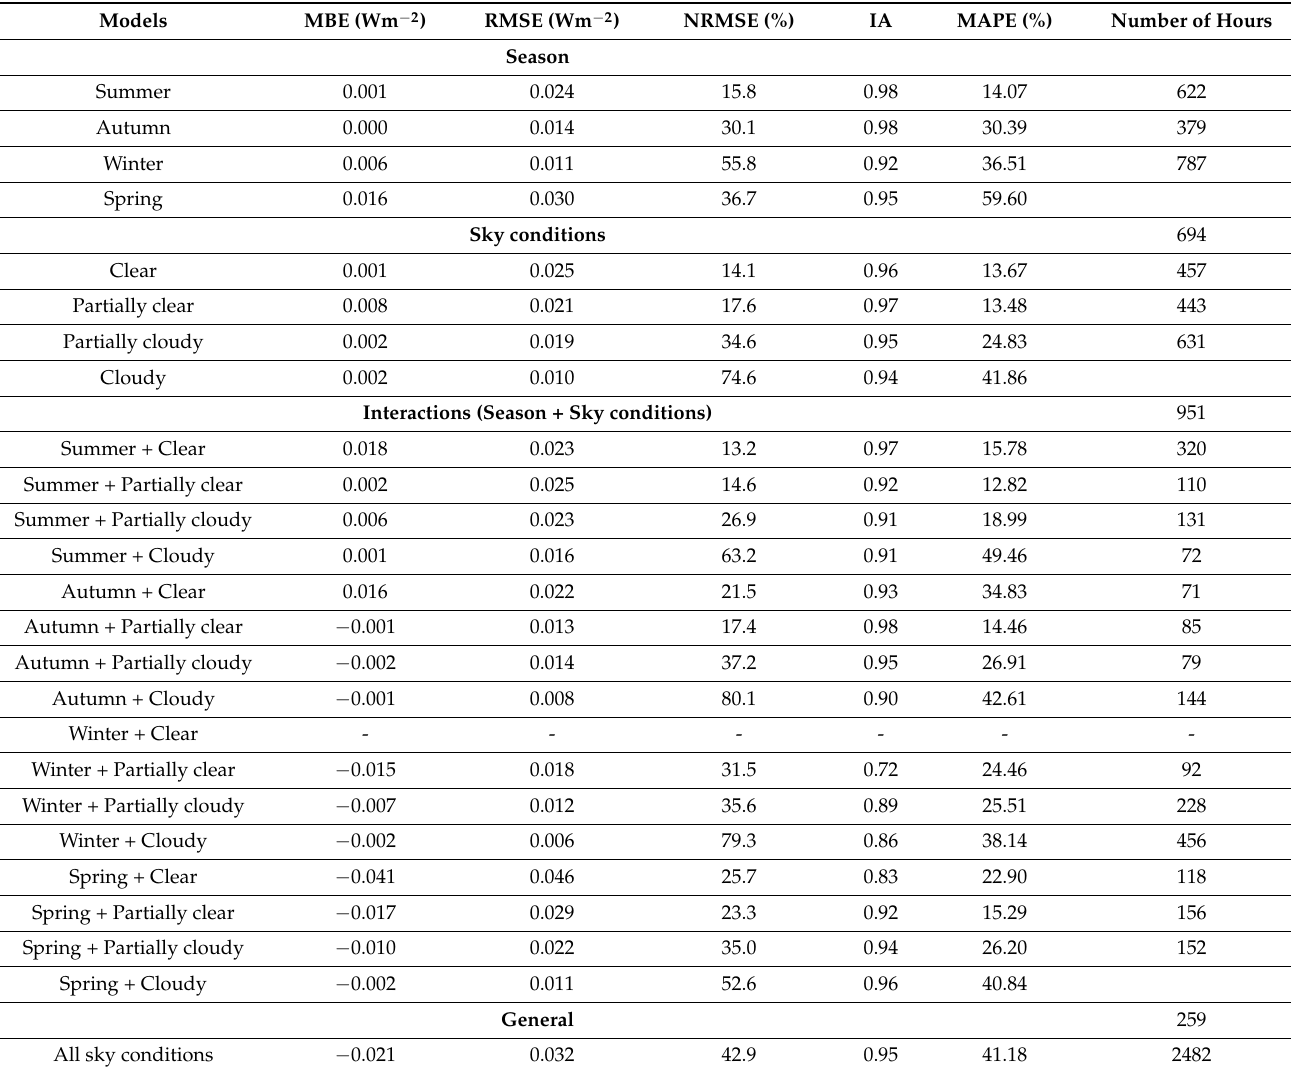
Table 4. Statistical parameters of the models for hourly values of UVER in Santiago, Chile using observations carried out in